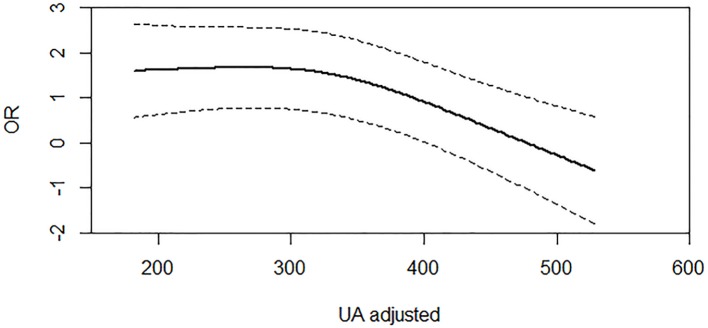
Association of serum UA (uric acid) levels with risk of PSD. Dashed lines are 95% confidence intervals. Odds ratios and 95% confidence intervals derived from restricted cubic spline regression (P for nonlinear = 0.0119). Odds ratios were estimated using logistic regression modeling, adjusting for the same variables as model 3 in Table 4.